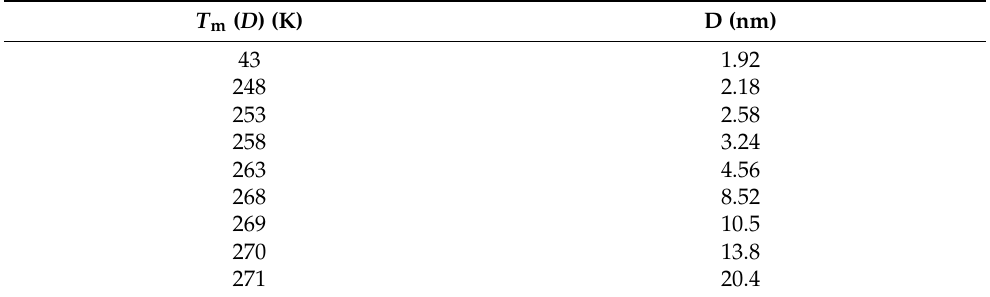
Table 2. The relationship between temperature drops in melting point and pore